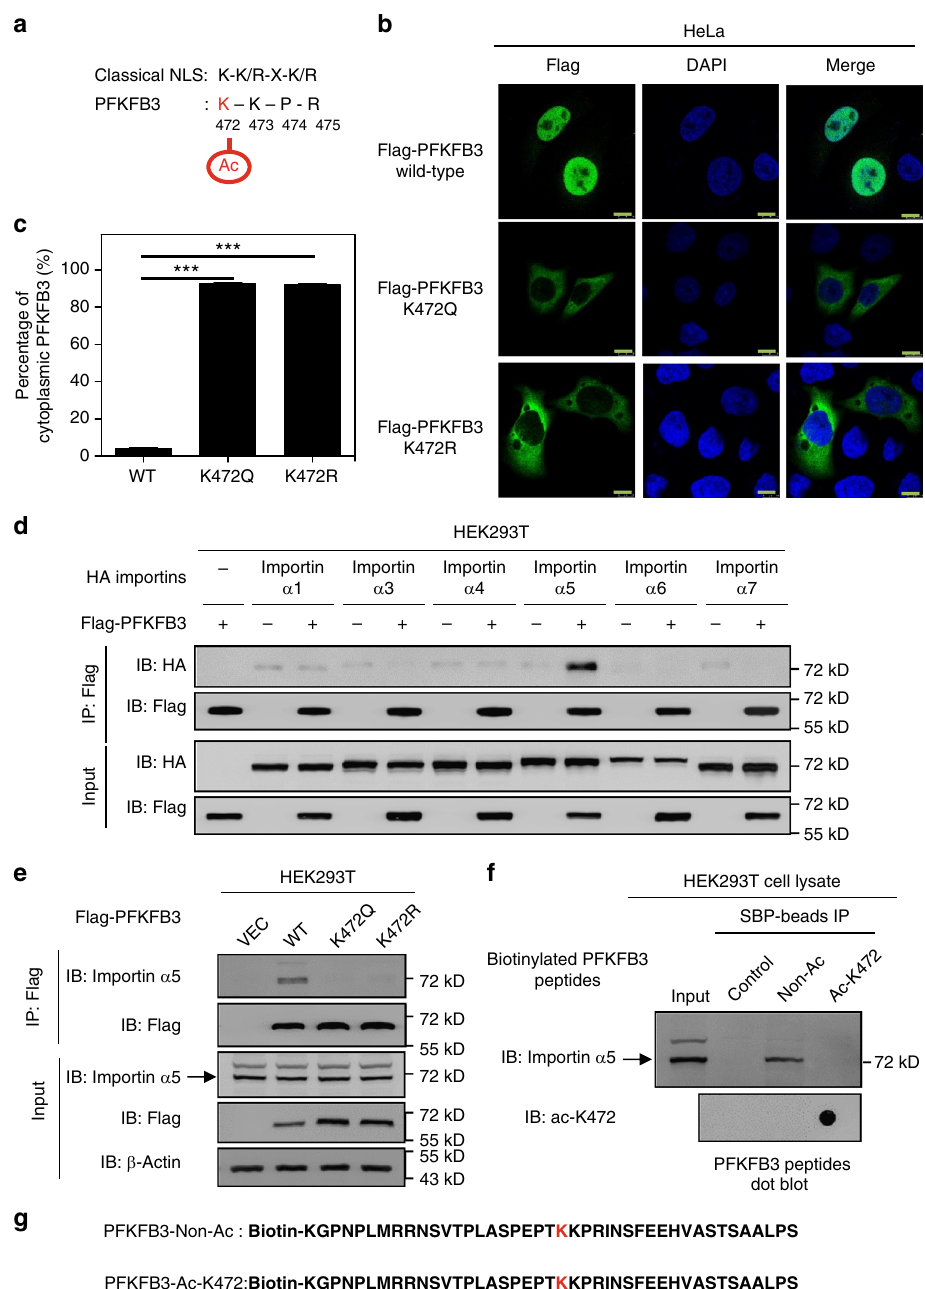
Fig. 3 Acetylation mimetic mutant of PFKFB3 disrupts its NLS motif. a K472 is located as the fi rst lysine of a putative NLS motif. Schematic representation of the consensus sequence K(K/R)X(R/K) of a classical nuclear localization signal is shown. b K472 mutation results in cytoplasmic accumulation